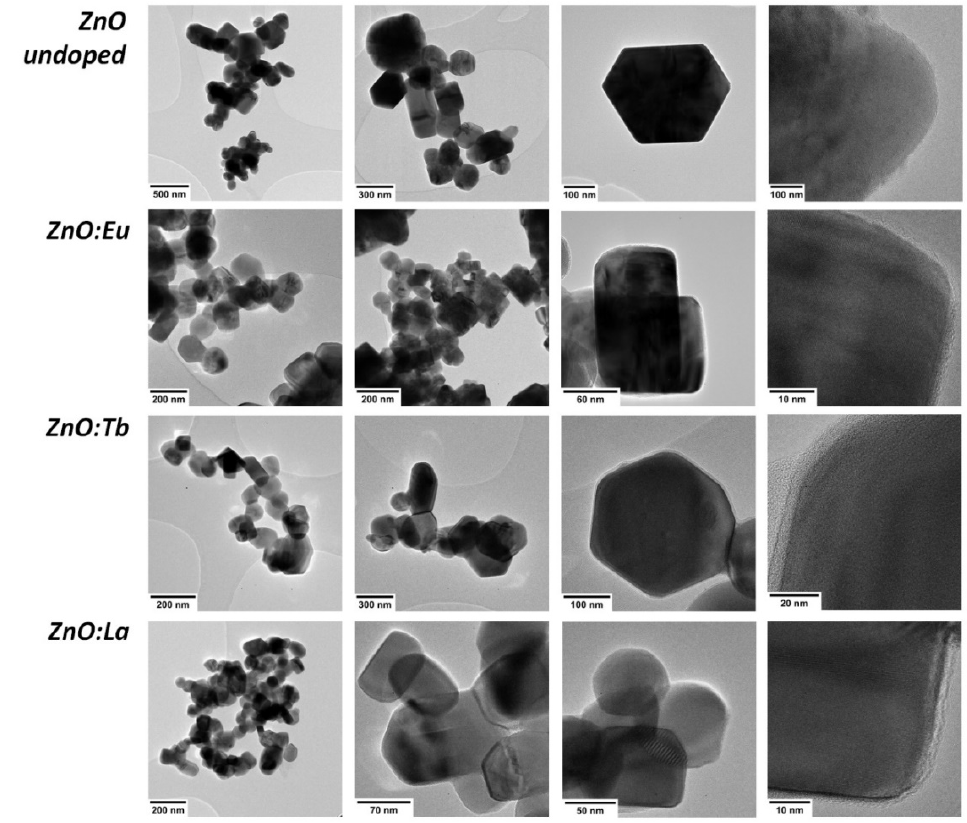
Figure 1. TEM images for different assemblies of nanocrystals from undoped ZnO NPs and lanthanide doped ZnO:Eu, ZnO:Tb, and ZnO:La NPs.